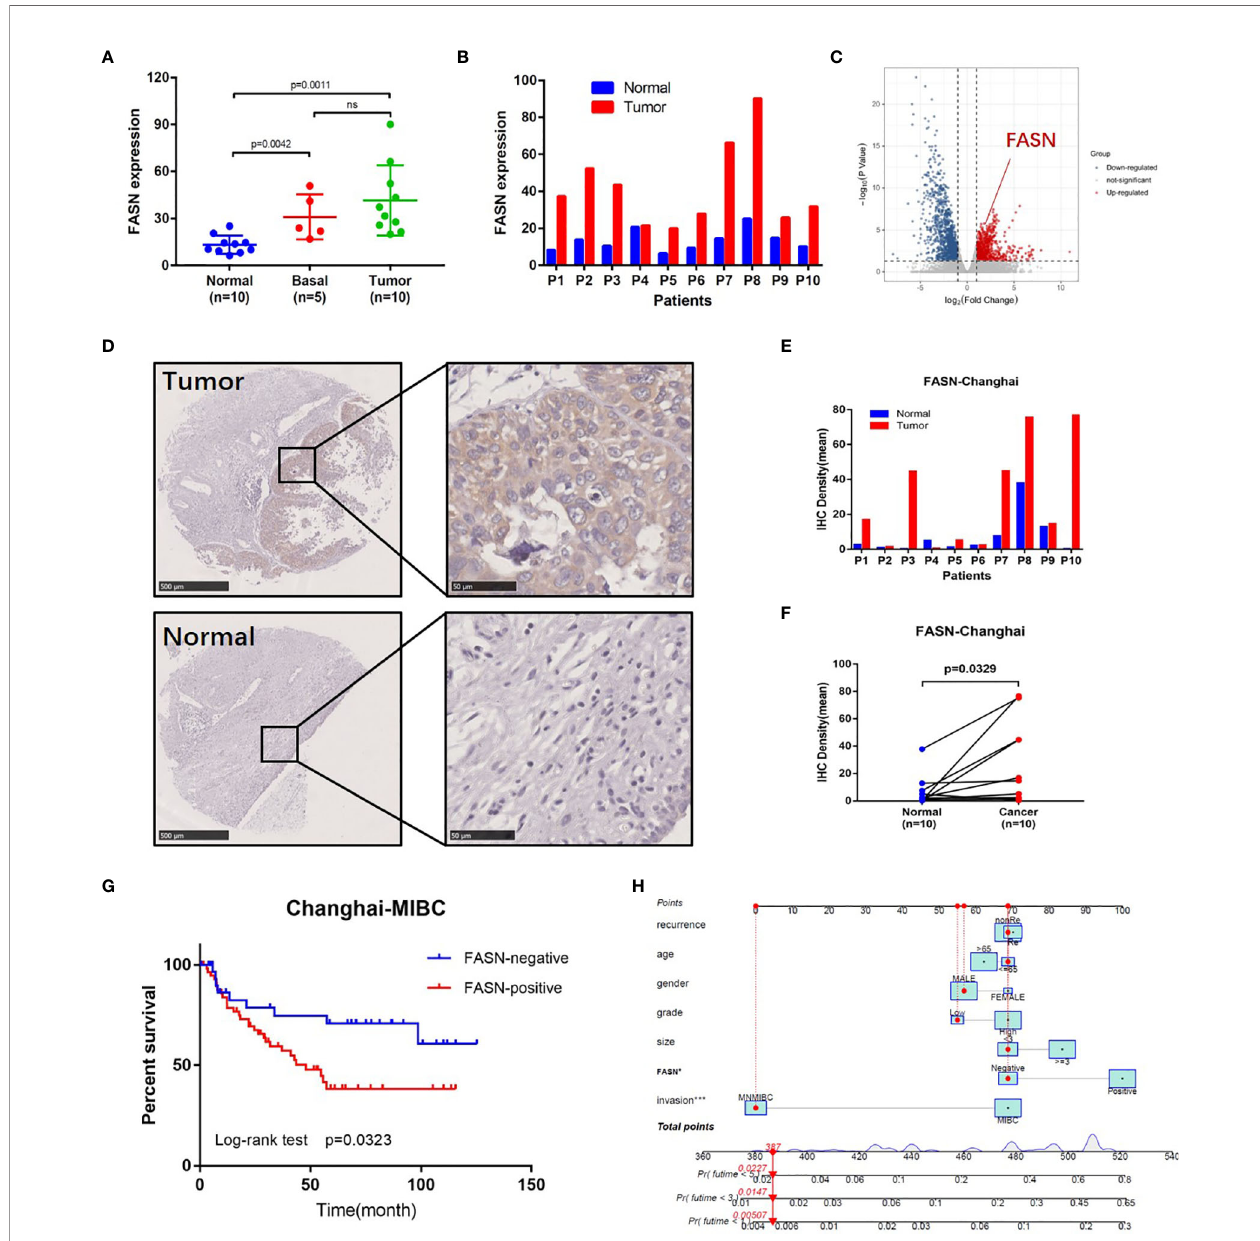
FIGURE 3 | External validation of FASN. (A) Differential expression of FASN in normal, basal and tumor tissues. (B) Differential expression of FASN in 10 paired normal and tumor tissues. (C) Volcano plot of paired tissue RNA-seq matrix (logFC>1, p<0.05). (D – F) IHC staining of the 10 paired normal and tumor tissues. (G) Overall survival curve between the positive and negative FASN groups of MIBC patients in the CH cohort. (H) Nomogram with FASN and clinicopathologic features for the prediction of outcome in the CH